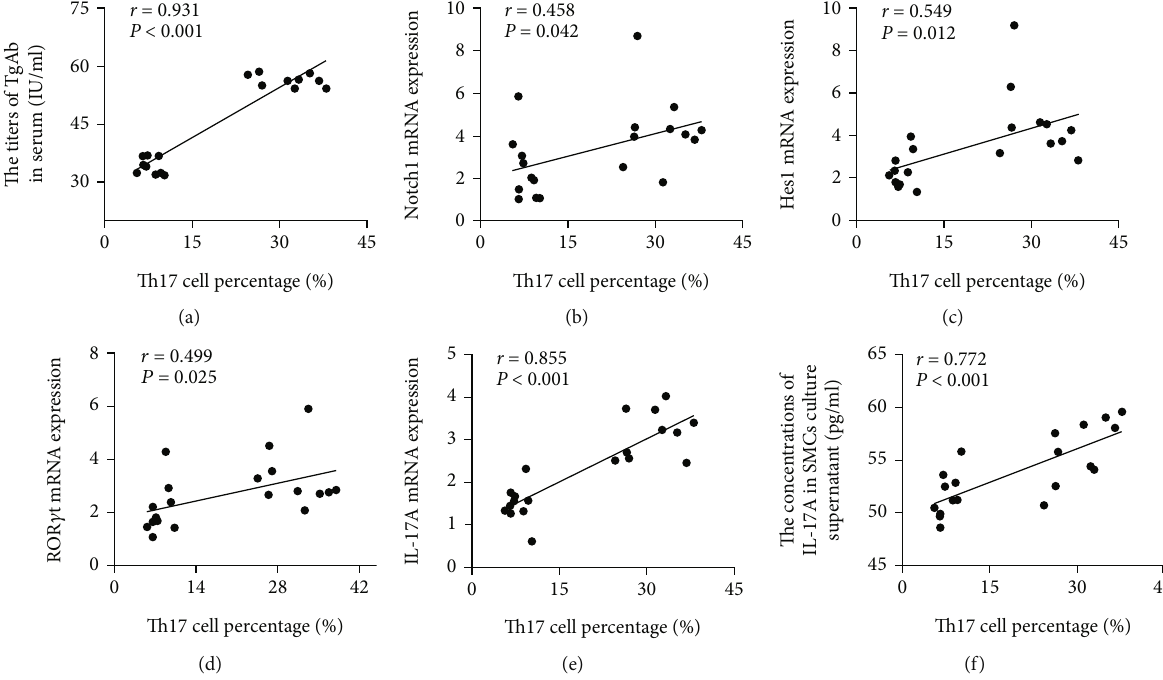
Figure 8: Correlation analyses of Th17 cells with TgAb and Notch signaling pathway-related components in EAT-A mice ( n = 20 ). Th17 cell percentages positively correlated with (a) serum TgAb titers ( r = 0 : 931 , P < 0 : 001 ), (b) Notch1 mRNA expression ( r = 0 : 458 , P = 0 : 042 ), (c) Hes1 mRNA expression ( r = 0 : 549 , P = 0 : 012 ), (d) ROR γ t mRNA expression ( r = 0 : 499 , P = 0 : 025 ), (e) IL-17A mRNA expression ( r = 0 : 855 , P < 0 : 001 ), and (f) IL-17A concentration in SMC culture supernatant ( r = 0 : 772 , P < 0 : 001